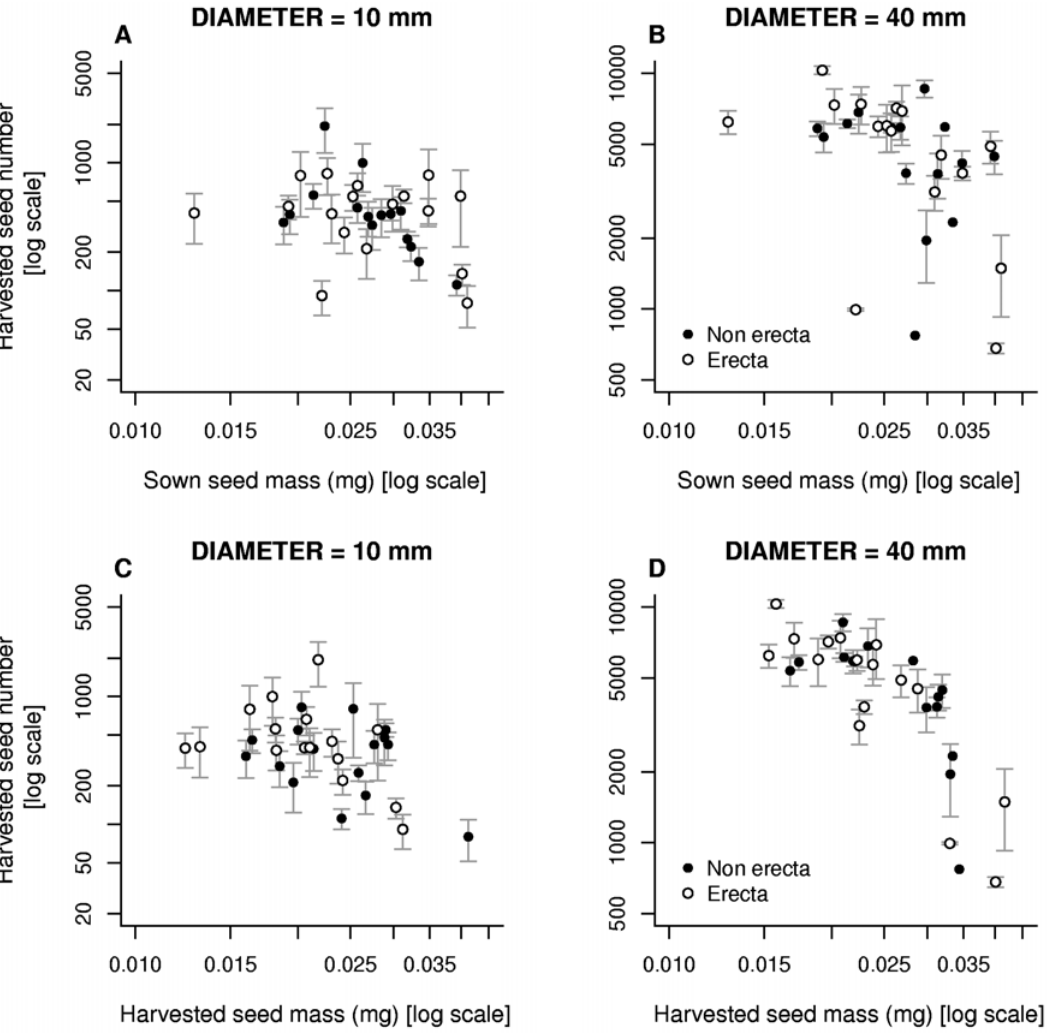
Figure 5. The relationship between the number of seeds produced and both sown seed mass and harvested seed mass. Points show the mean ( 6 1 s.e.m) of all individuals belonging to the same line.